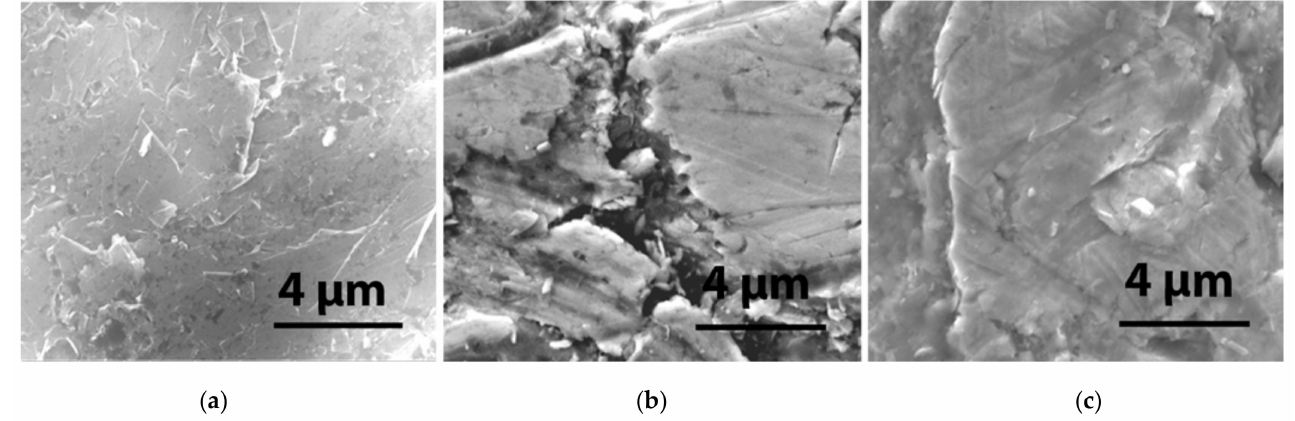
Figure 2. High-magnification images ( × 20,000) of the W surface in the pristine samples: ( a ) W-Cr-Ti; ( b ) W-Cu and ( c ) W-V.